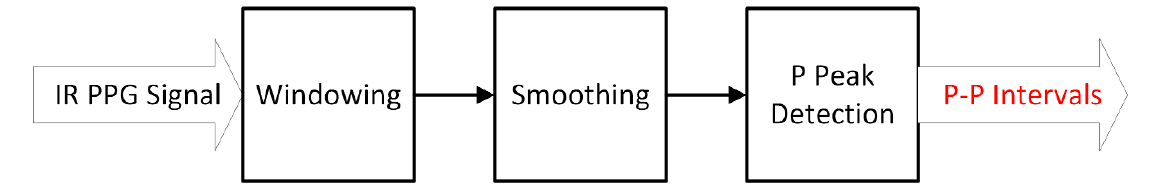
Figure 6. Block diagram of the PPG technique.